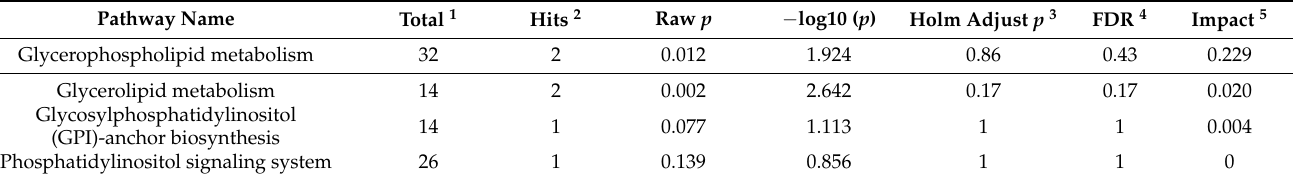
Figure 5. Volcano plot analysis of 100 µ g/mL CV-treated vs. the control in the positive ( A ) and negative ( C ) modes, and 200- µ g/mL CV-treated vs. the control in the positive ( B ) and negative ( D ) mode. Table 2. Results from the ingenuity pathway analysis with Metaboanalyst in the 200- µ g/mL group vs. control